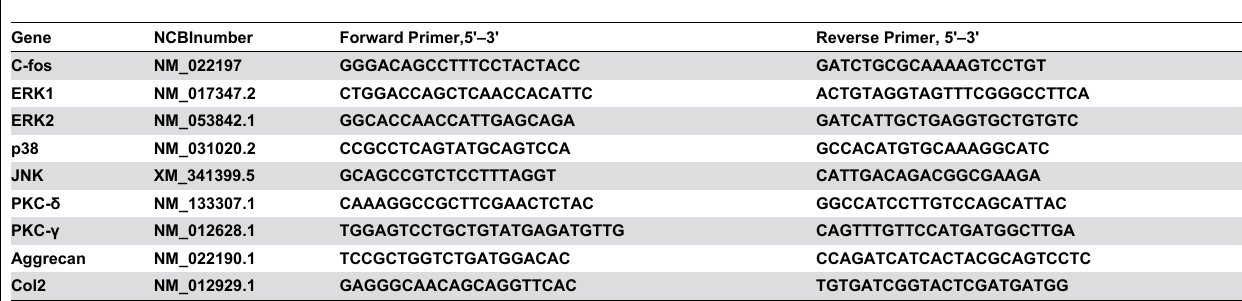
Table 1. Transcripts and sequences of each primer used in real -time